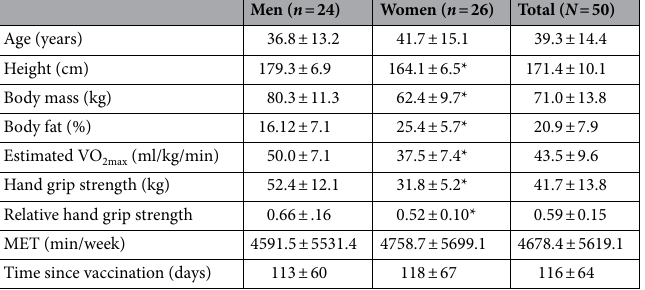
Table 1. Participant demographics. MET Metabolic equivalent of task. Estimated